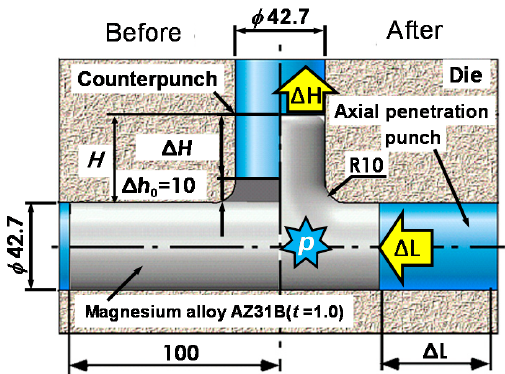
Figure 2. Outline of the tooling for T-shape forming (Unit: mm).